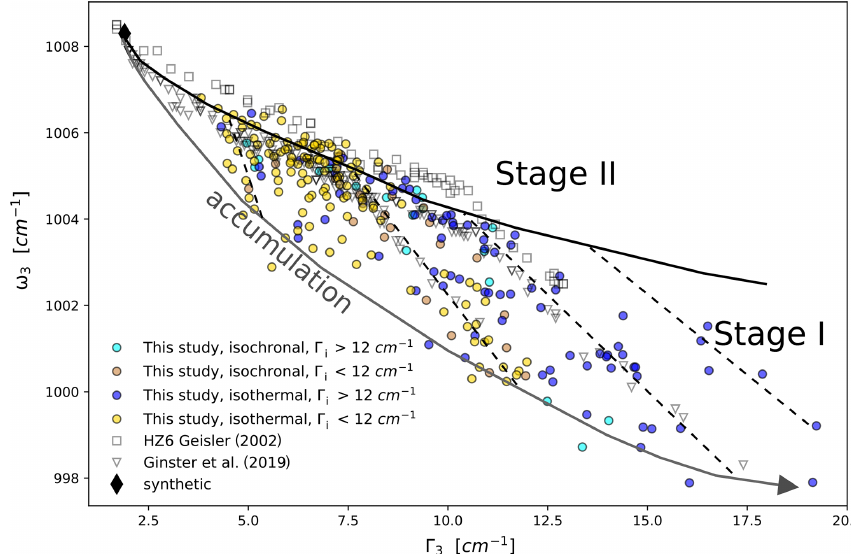
Figure 6. Composite ω – (cid:48) plot of the ν 3 (SiO 4 ) annealing data from this study compared with published data (Geisler, 2002; Ginster et al., 2019). The data are subdivided into isochronal and isothermal runs and samples larger and smaller than an initial (cid:48) 3 of 12cm − 1 ( ∼ 70 × 10 16 α /g). Gray arrow: radiation-damage accumulation trajectory based on the unannealed zircons from this study; dashed black lines: stage I annealing; bold black line: stage II